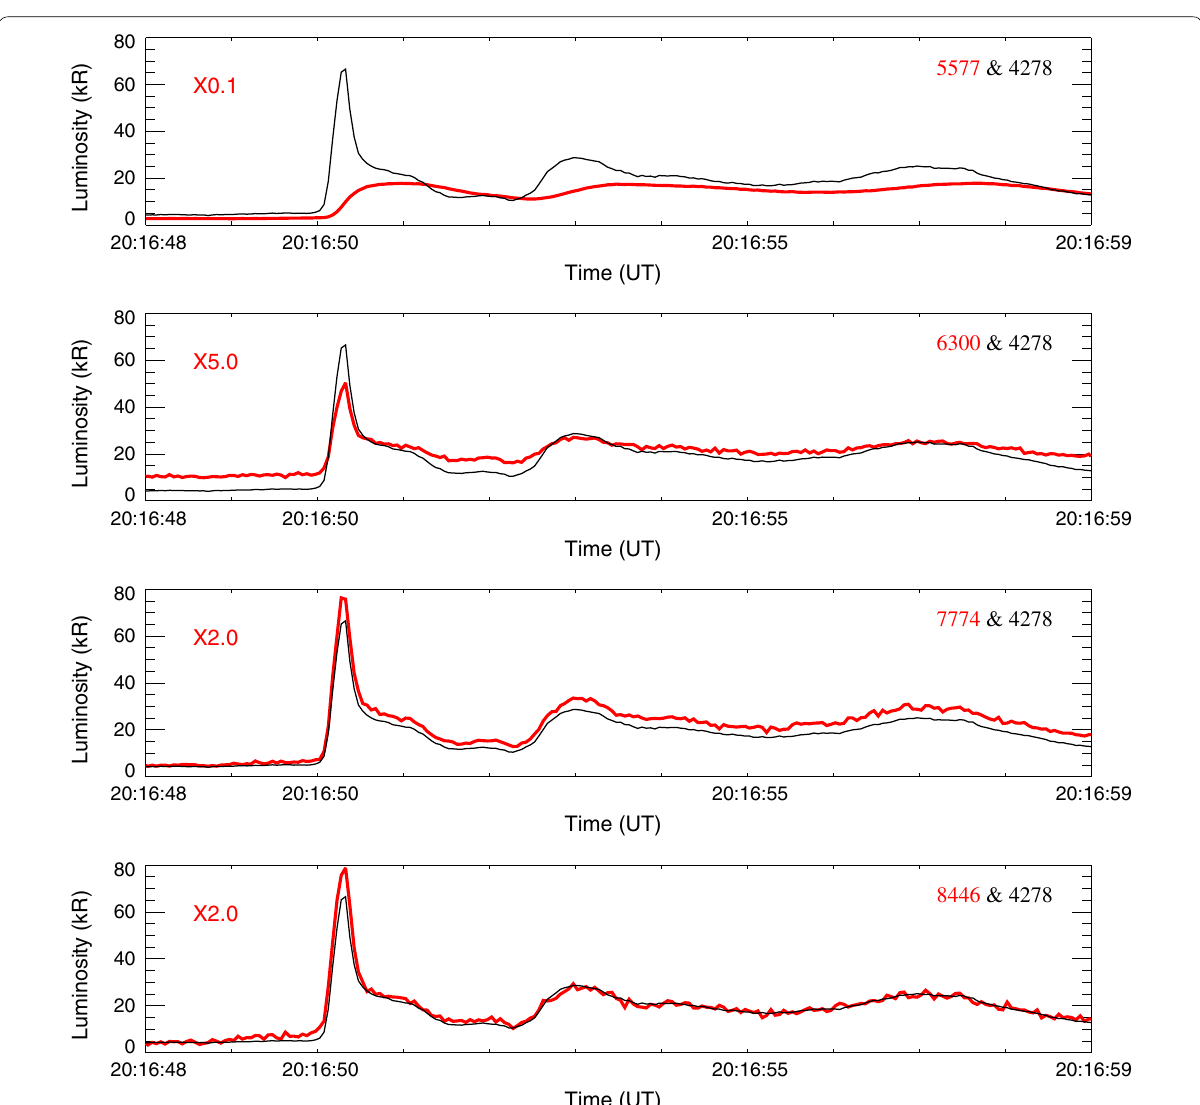
Fig. 7 Comparisons of temporal variations of auroral emissions (20 Hz data) between 427.8 nm (black solid line) and 557.7 nm, 630 nm, 777.4 nm, and 844.6 nm from top to bottom are presented for 11 s between 20:16:48 UT and 20:16:59 UT on October 19, 2017. The emission intensity values of 557. 7 nm, 630 nm, 777.4 nm, and 844.6 nm are multiplied by 0.1, 5, 2, and 2, respectively, and denoted in red solid